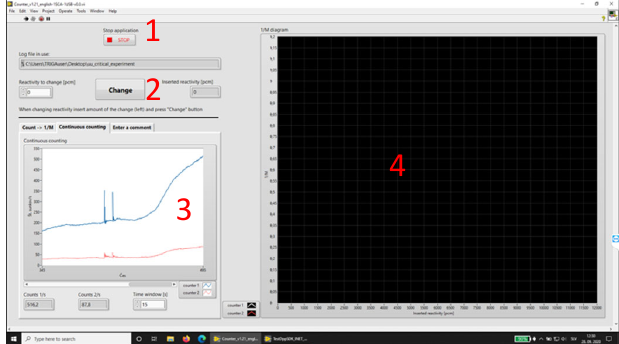
Figure 3 Digital acquisition software was remotely controlled by the students. The purpose of the application on screenshot above was to measure the number of counts in the start-up channel and assist in plotting the 1/M diagram. The students were able to start and stop the application by pressing the Start/Stop button (1), enter the inserted reactivity or differences in inserted reactivity (2) perform